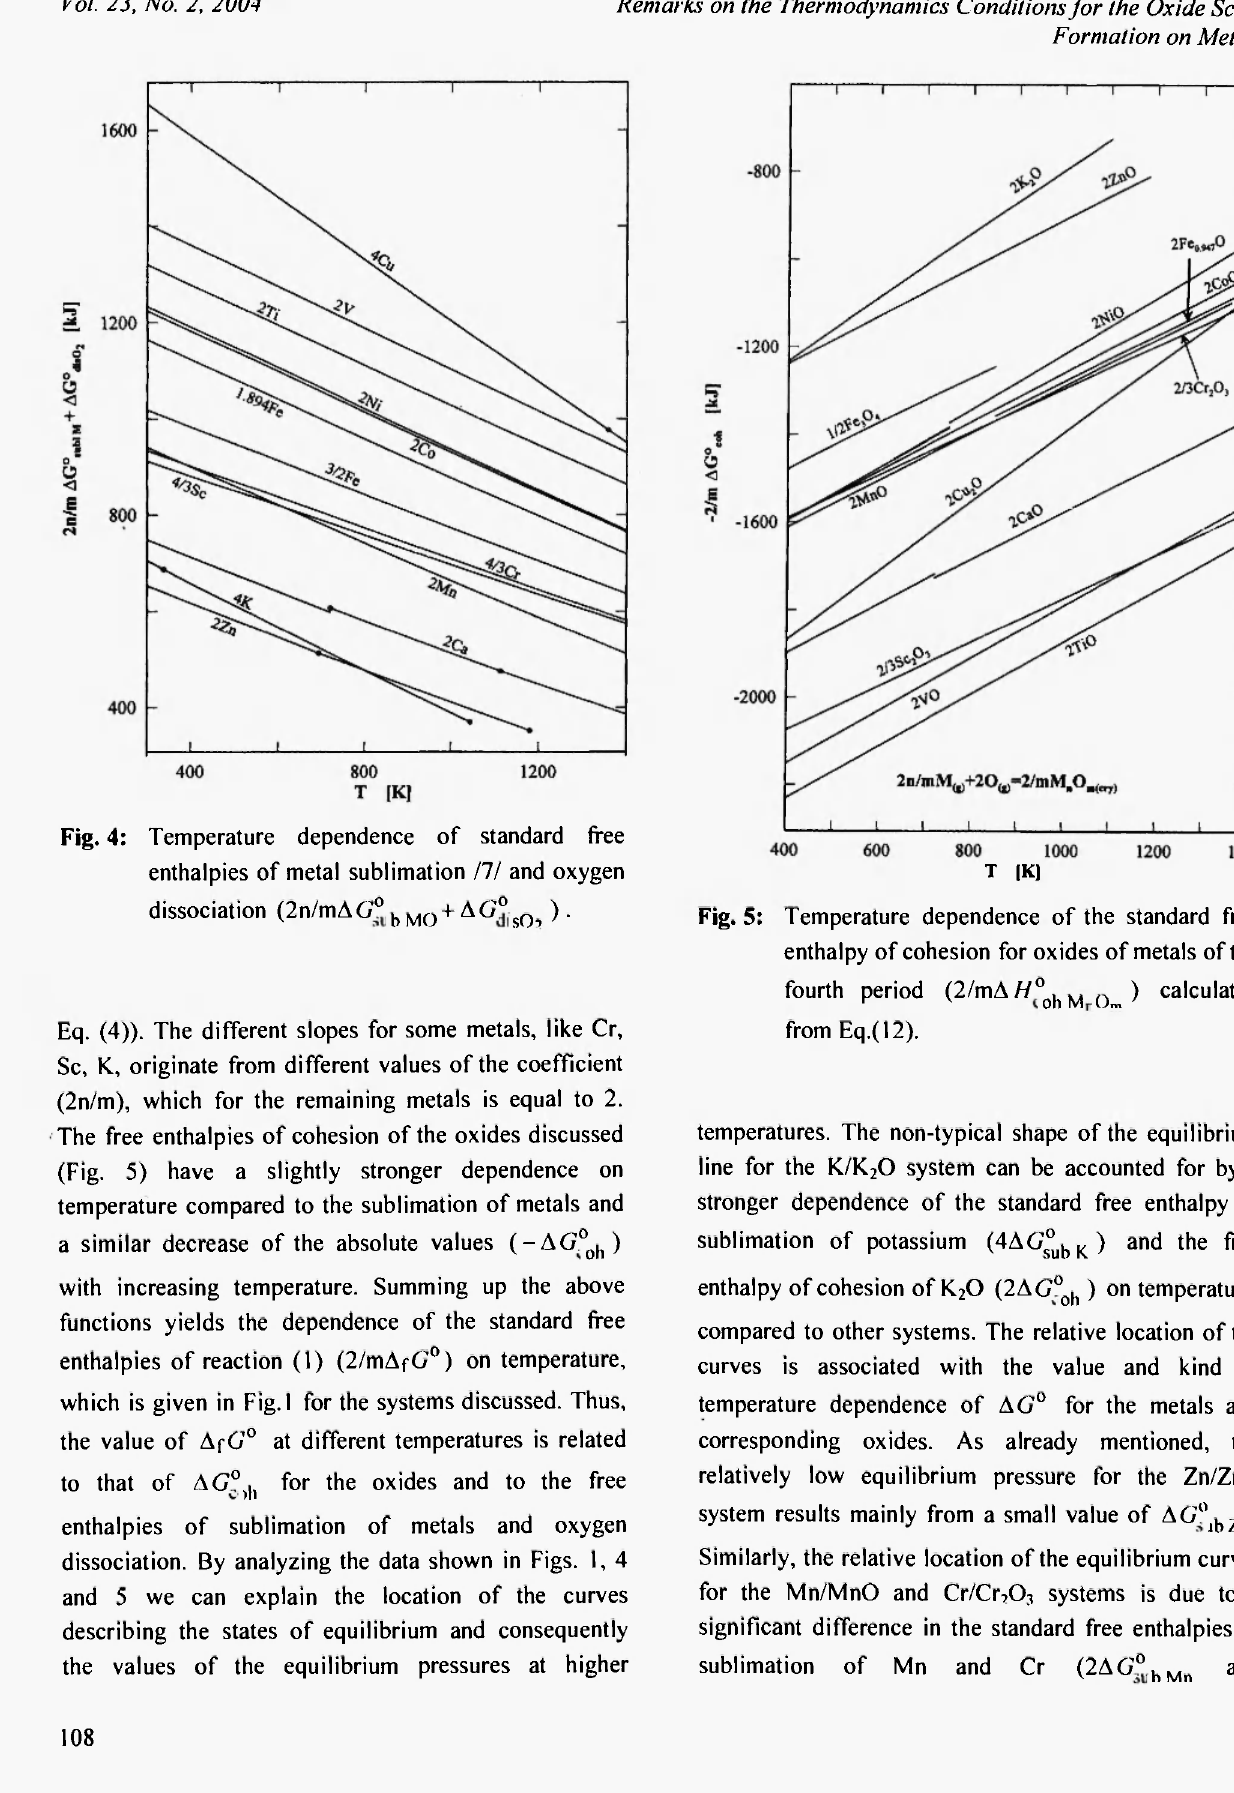
Fig. 4: Temperature dependence of standard free enthalpies of metal sublimation 111 and oxygen dissociation (2n/mAG° bMO + Δ G ° s 0i ) .